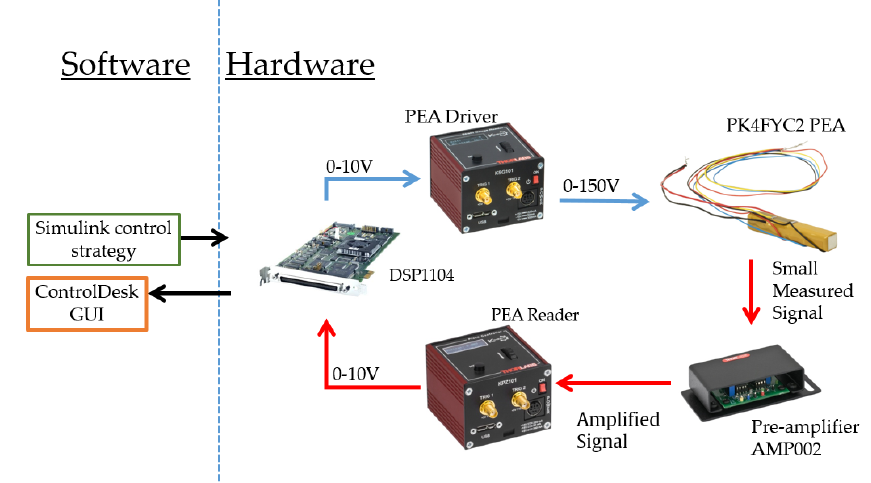
Figure 1. Software-hardware flow diagram used in the